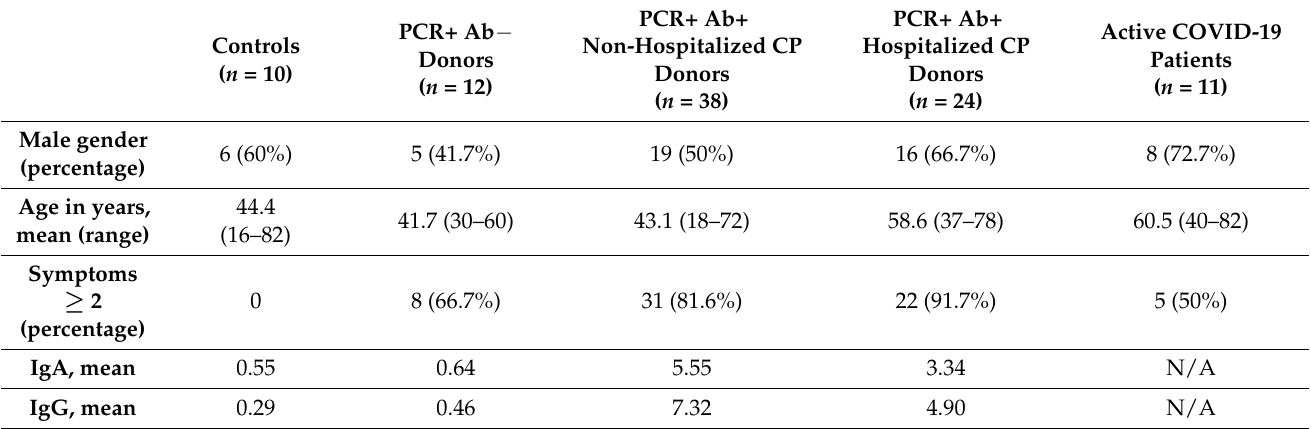
Table 1. Demographic and clinical characteristics of COVID-19 related